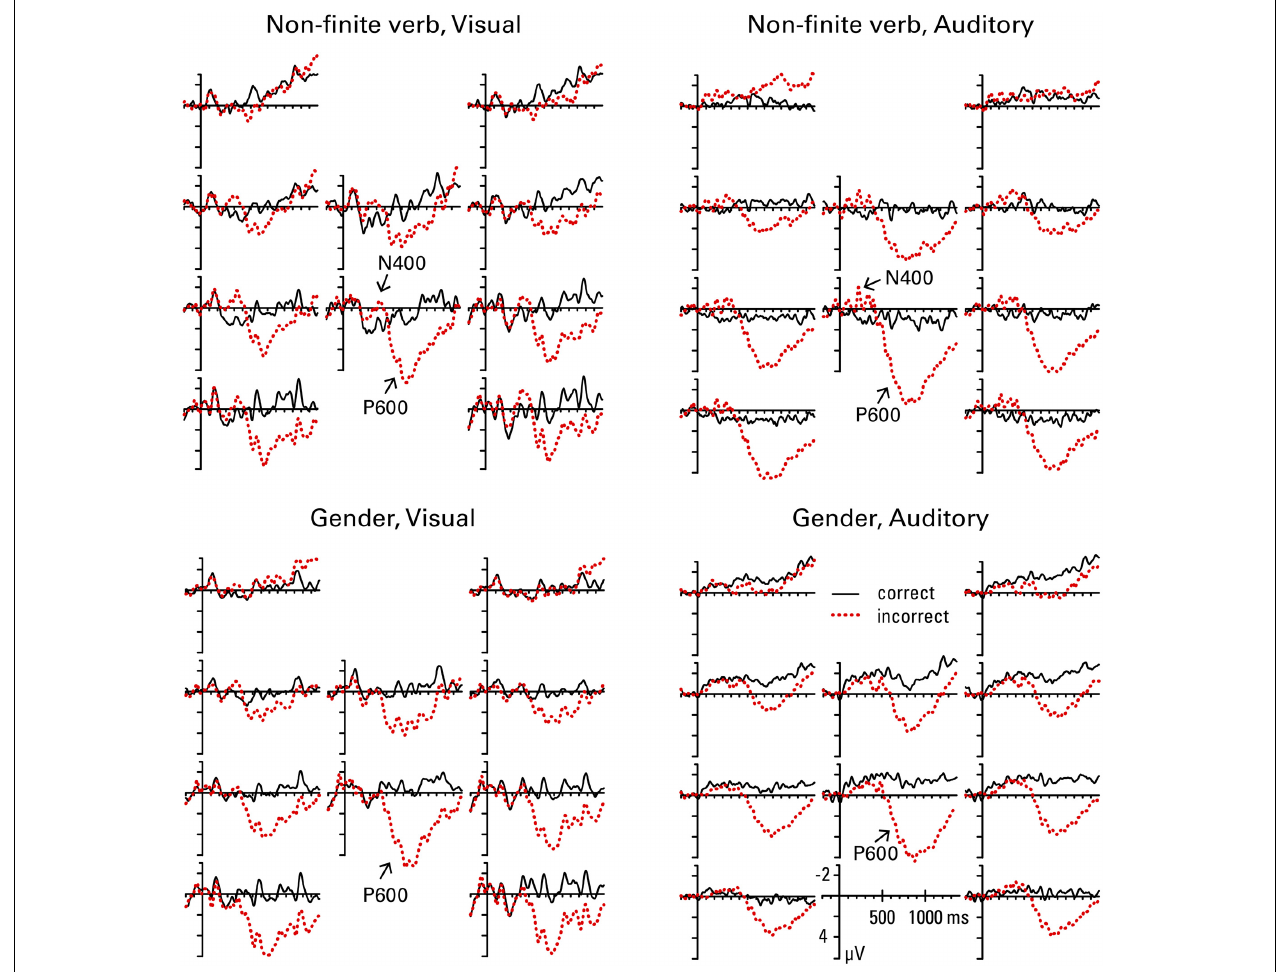
FIGURE 3 | Natives’ grand average ERP waveforms at all 10 regions of interest (see Figure 1) for correct and incorrect use of non-finite verb and gender agreement in the visual and the auditory condition.